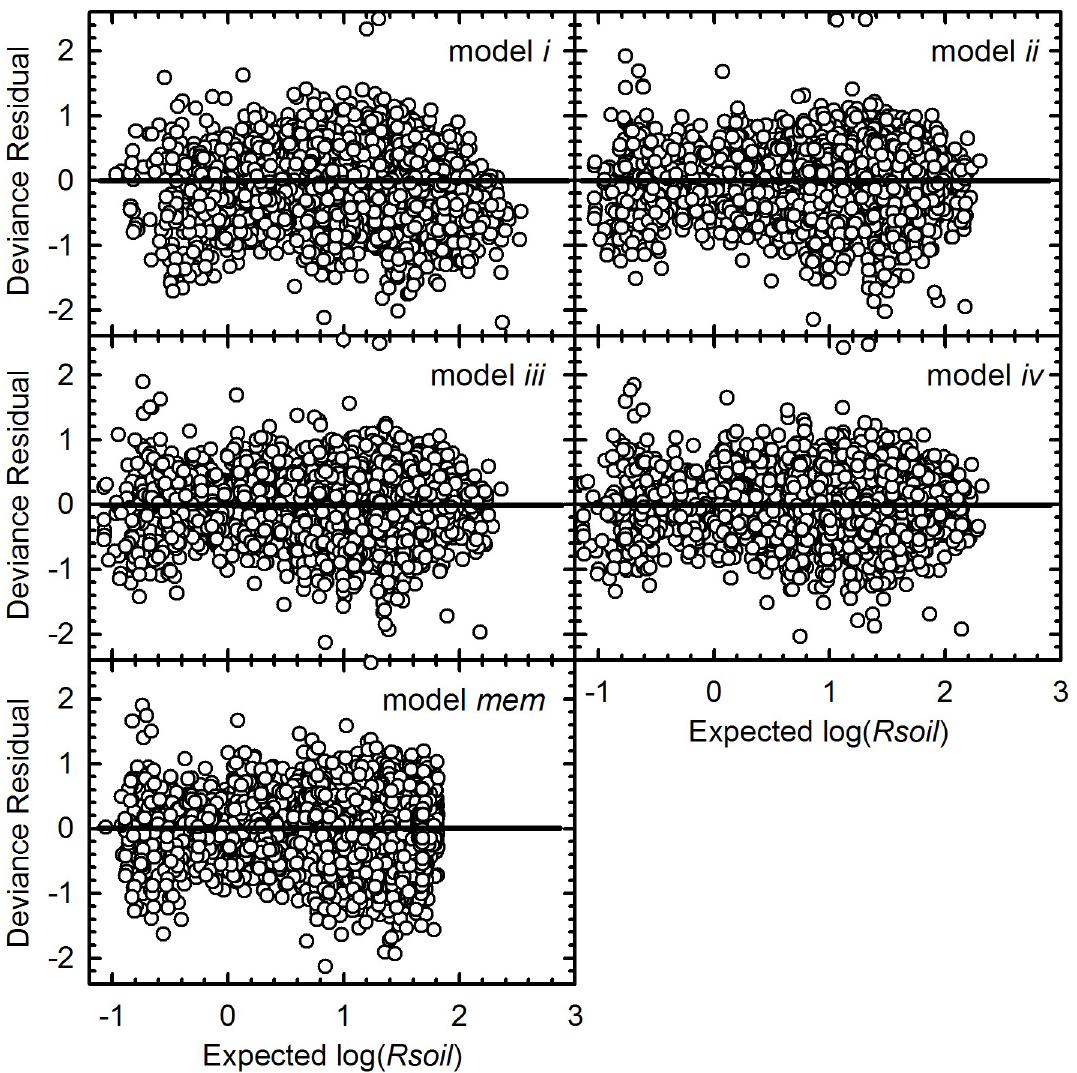
Fig 1. Deviance residuals of the five tested models, based on all observed data. The main-effects model ( mem ) included only the main effects, without interactions: Tsoil , Tsoil 2 , VWC, VWC 2 , EVI and Tair . Horizontal lines divide each plot into positive and negative residuals, for ease of interpretation: the sample size for each is